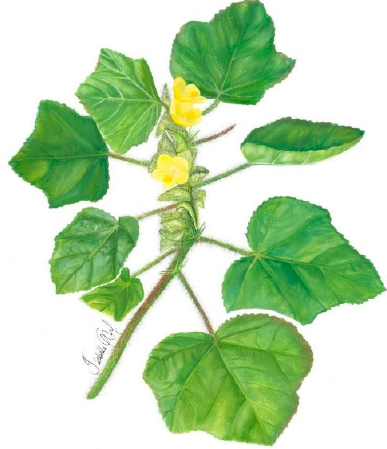
Figure 1. Malachra alceifolia Jacq.